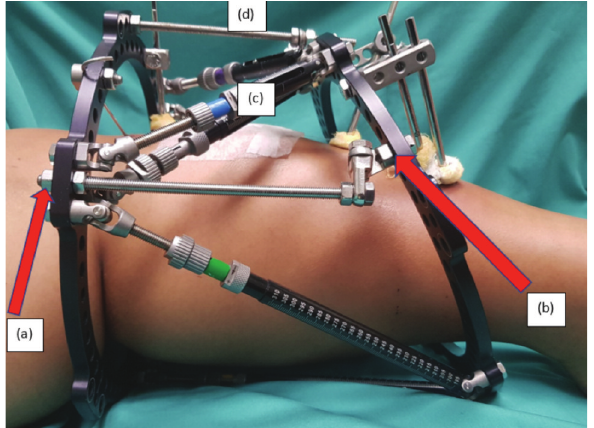
(a) Fixation of the triple hinge pillar begins with the application of the threaded rod onto 1 ring. (b) Next the loosened triple Fig. 2: hinge unit is arranged to allow fixation onto the next ring. The strut (c) can now be removed. Another triple hinge unit (d) can also be added for multiple struts change.